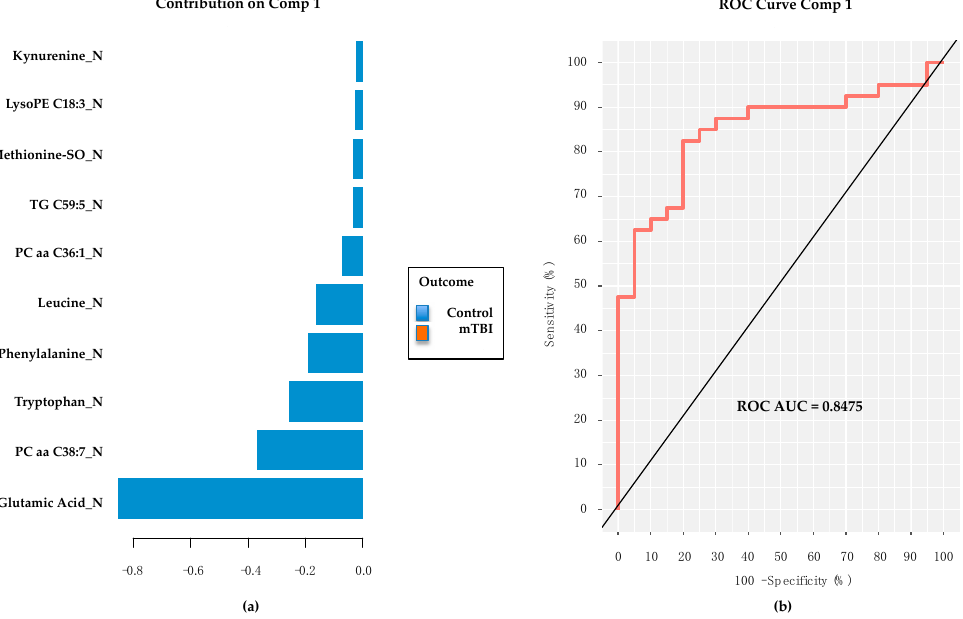
Figure 5. Contribution plot and classification performance of 10 metabolites derived via sPLS-DA from PD/PPD/Control subjects. ( a ) Glutamic Acid continues to provide the major contribution to the classification performance of this preliminarily annotated 10-metabolite panel. ( b ) A similar ROC AUC is obtained in new discovery with these data as had been obtained using the subacute TBI biomarker panel’s 9 preliminarily annotated common metabolites (see Figure 4). Of interest, the only common metabolite between these results and those from the TBI panel is Glutamic Acid. Comp = sPLS-DA model component. TBI = traumatic brain injury. PD = Parkinson’s disease. PDD = PD dementia. ROC AUC = receiver operating characteristic area under the curve. LysoPE = lysophosphatidylethanolamine. SO = sulfoxide. TG = triglyceride. P = phosphatidylcholine. Final metabolite identifications will require additional tandem mass spectrometry (MS/MS) analyses. Metabolites confirmed via MS/MS are considered fully validated, to a high degree of